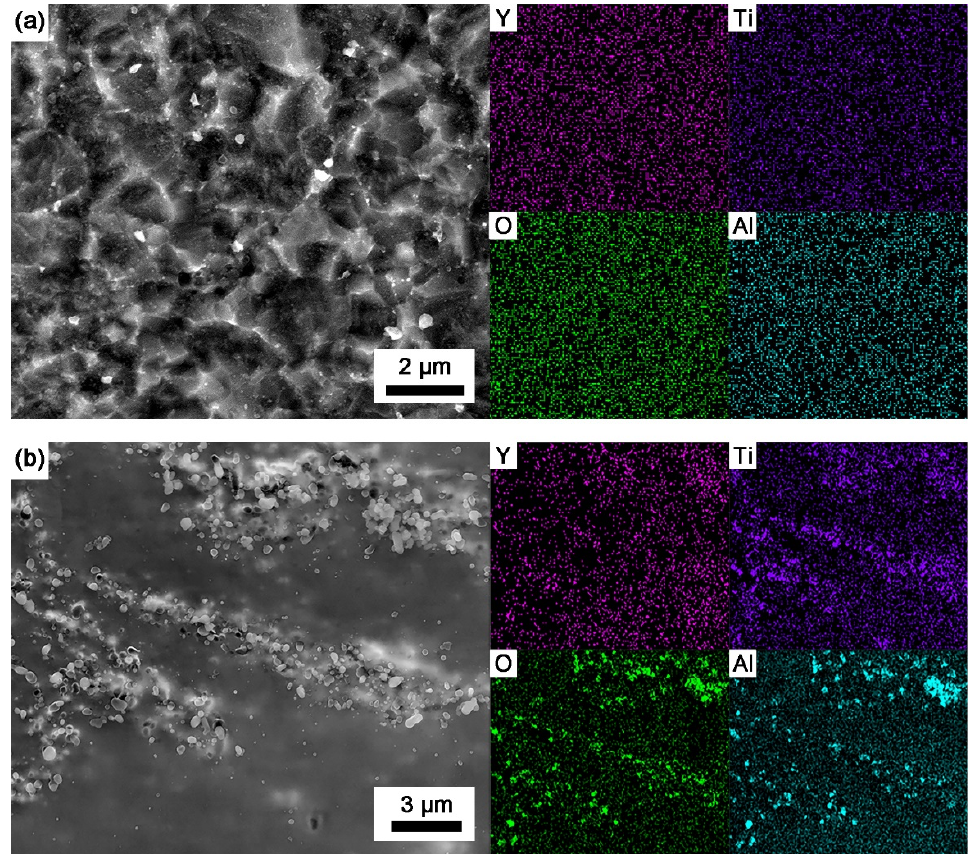
Figure 3. SEM secondary electron image and corresponding element distribution mapping of a TEM foil of as ‐ HIP ‐ treated ( a ) S1 and ( b ) S2.